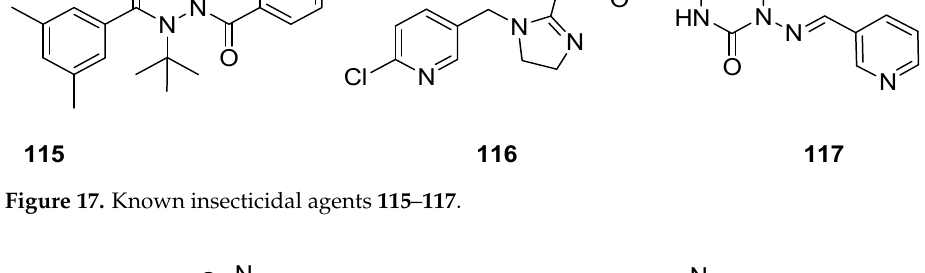
Figure 16. 1,2,3-Thiadiazole dehydroepiandrosterone derivative 114 as new antitumor agents.